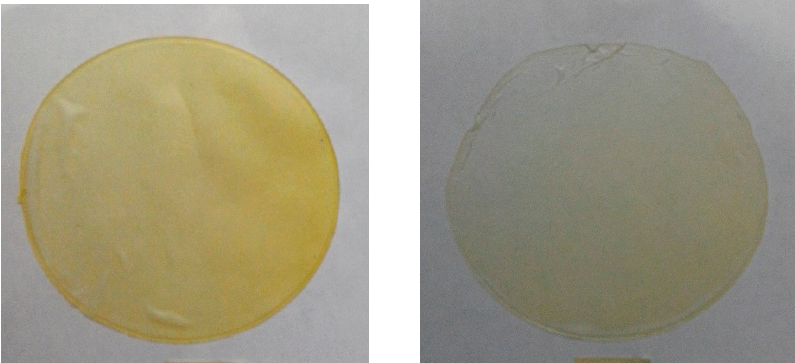
Figure 2. Colors of films with the addition of nanoemulsions 1:01 and 1:1 .